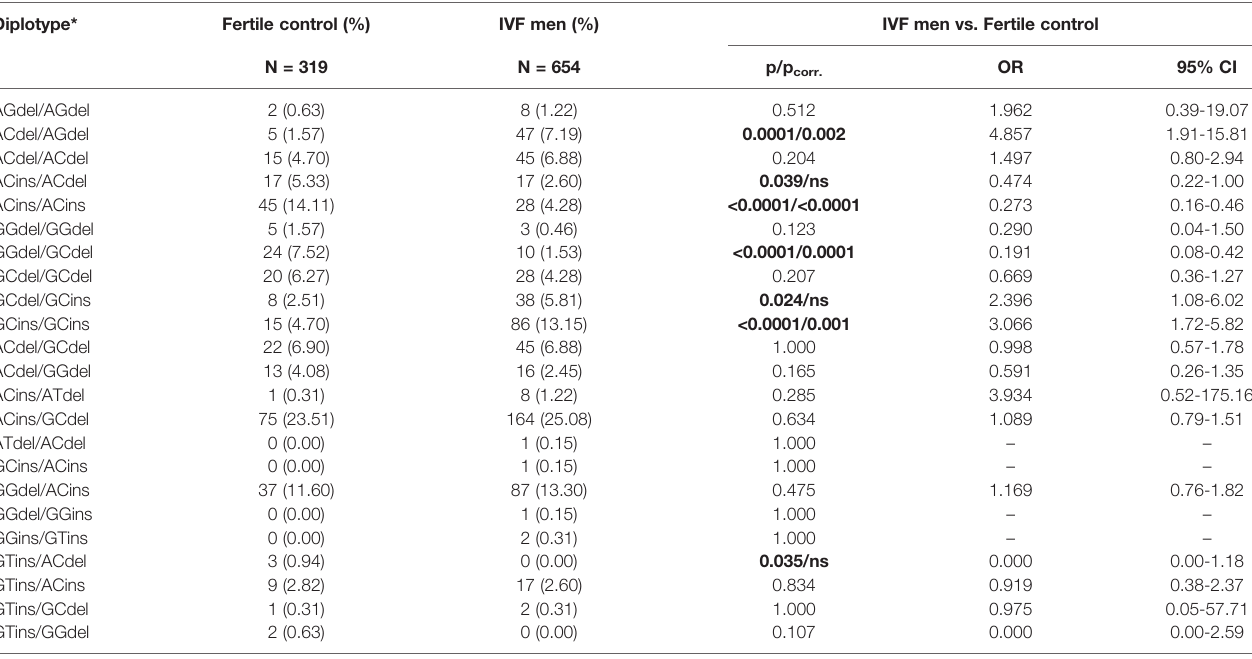
TABLE 2 | HLA-G diplotype frequencies in men from Control and IVF groups. Diplotype* Fertile control (%)